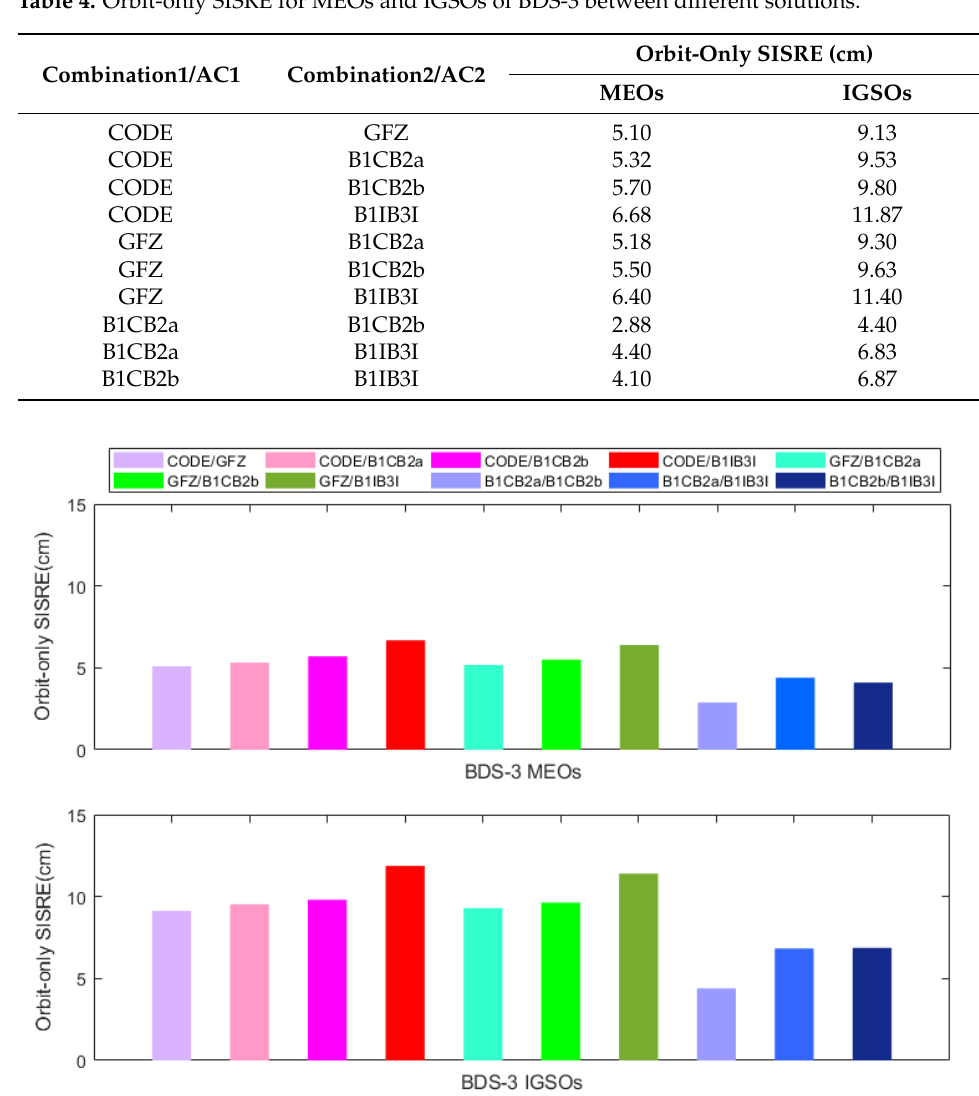
Figure 7. Histogram of the orbit-only SISRE for MEOs and IGSOs of BDS-3 between different solu-